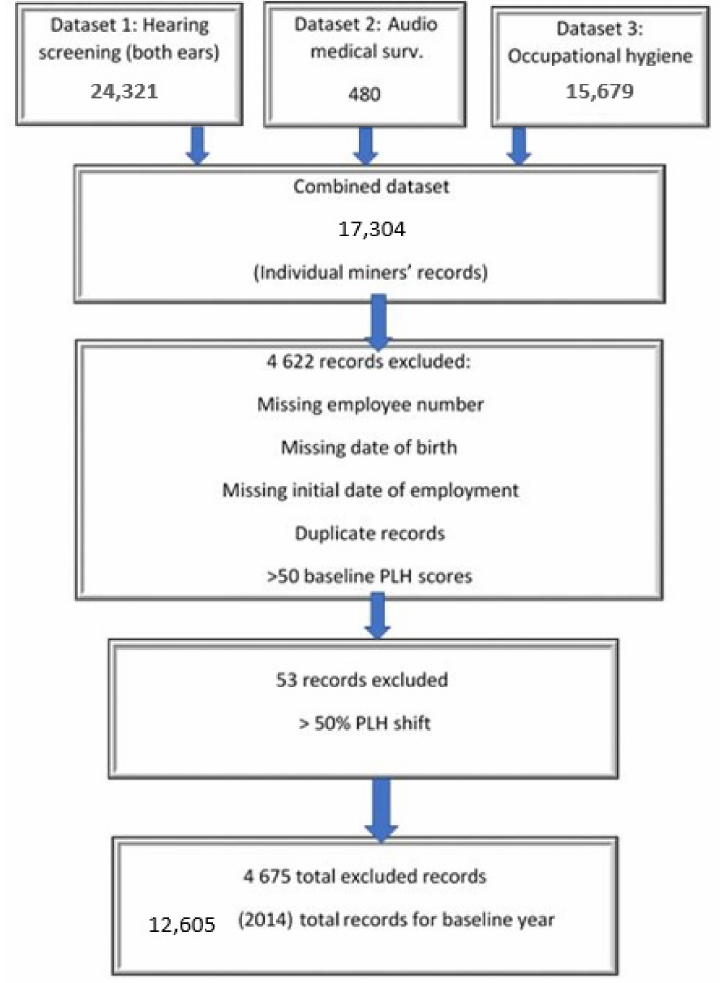
Figure 1. Data management process followed showing individual miners’ records included and those excluded from merged